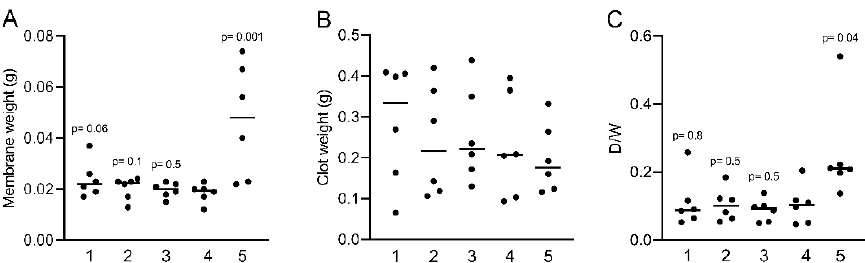
Figure 2. Measuring the clottable fraction of liquid PRF. ( A , B ) The weight of clotted liquid PRF prepared at 2000 × g before and after compressing is indicated. ( C ) The ratio of the pure clotted fibrinogen against total clottable fibrinogen was calculated dry weight/wet weight (D/W). Statistical analysis was based on the Friedman test, and p -values are indicated compared to fraction 4 ( N = 6). Significance was set at p < 0.05.